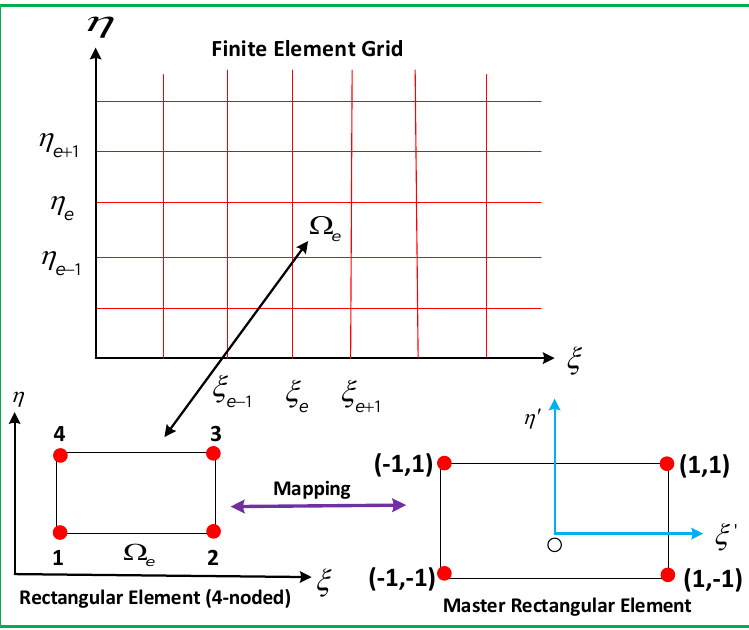
Figure 2. Finite element grid and finite element mesh of rectangular element.